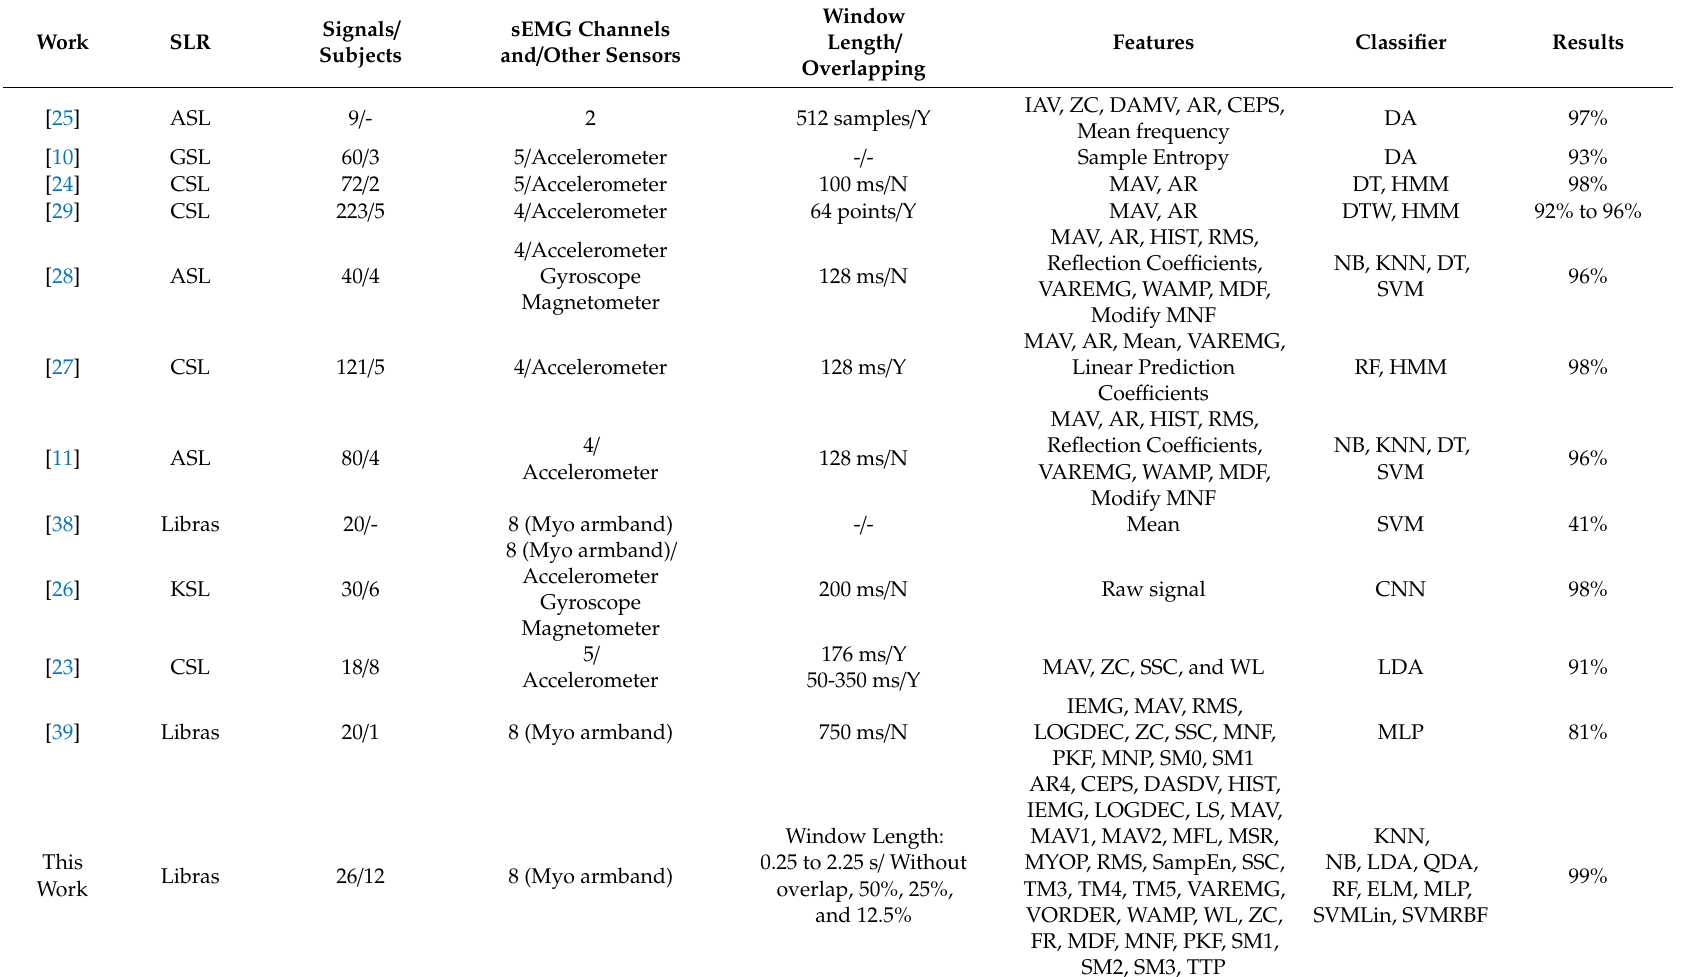
Table 5. Sign Language recognition (SLR) systems with sEMG as input and their main